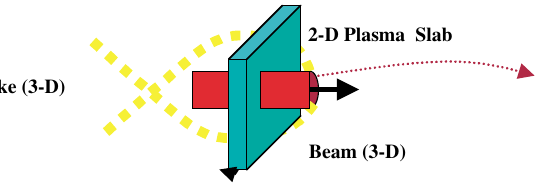
FIG. 2. (Color) QUICKPIC cycle. A 2D Poisson solver is used to calculate potentials and update positions and velocities in the plasma slab. After the slab is stepped through the beam, the stored potentials (cid:1) and ’ are used to push the 3D